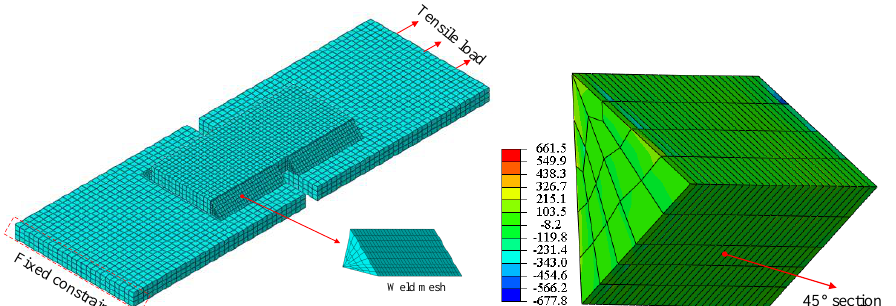
Figure 12. FEM and nodal force distribution of the standard shear specimen.